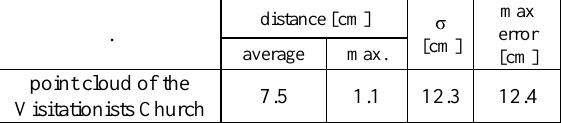
Figure 15. Accuracy assessment of a point cloud of the Visitationists Church generated from video frames with a 60% overlap a) in graphical form and b) as a plot.